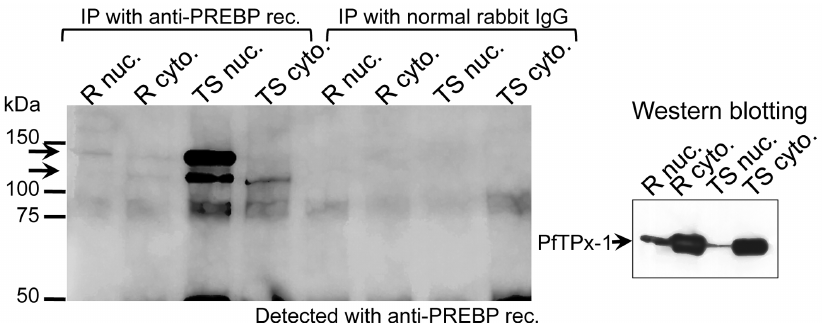
Figure 5. Endogenous expression and cellular localization of PREBP protein. Left panel: Nuclear extract from trophozoite/schizont parasites was subjected to immunoprecipitation (IP) with anti-PREBP rec. or Normal Rabbit IgG. The IP products were separated in SDS-PAGE and blotted with the anti-PREBP rec. Arrows are shown to denote the bands considered to be endogenous PREBP. Right panel: Western blot with the PfTPx-1 antibody. To test the fractionation efficiency of each sample used for the IP-Western, 2 m g of each fraction was separated in 5–20% SDS-PAGE and blotted with the specific antiserum for PfTPx-1, a constitutive expressed cytoplasmic protein [15]. R nuc., R cyto., TS nuc., and TS cyto. indicate nuclear extract from ring stage parasites, cytoplasmic fraction from ring stage parasites, nuclear extract from trophozoite/schizont stage parasites and cytoplasmic fraction from trophozoite/schizont stage parasites, respectively.